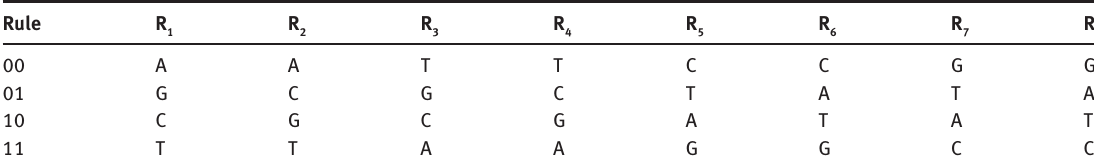
Table 1: Map Rules of DNA